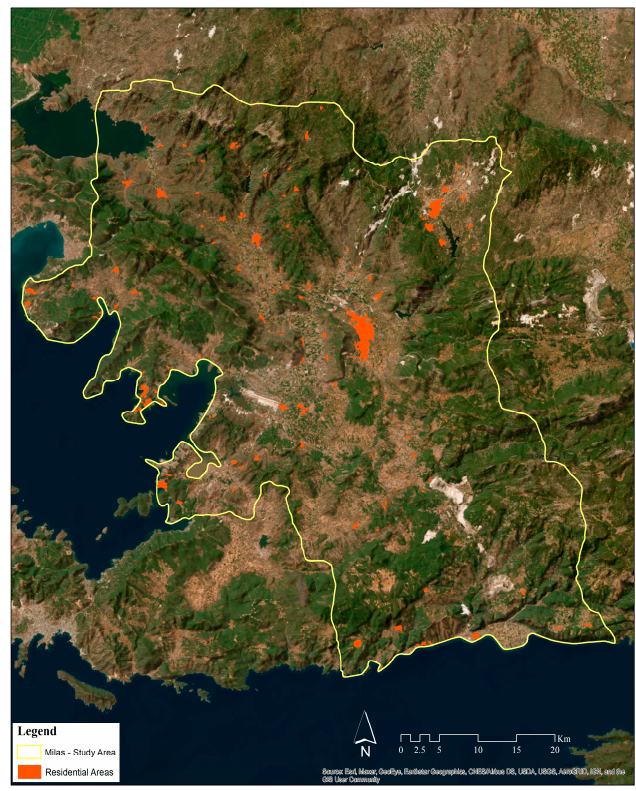
Figure 11. Residential areas.